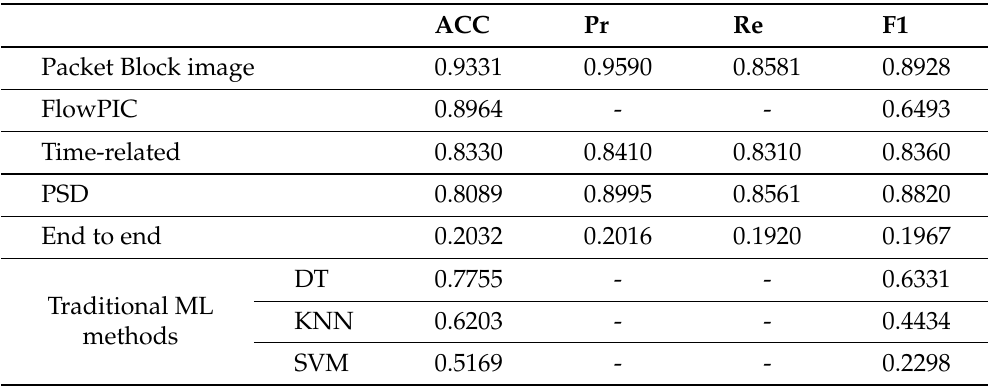
Figure 8. Confusion matrix in ISCX-tor dataset. Table 7. Results compared with related